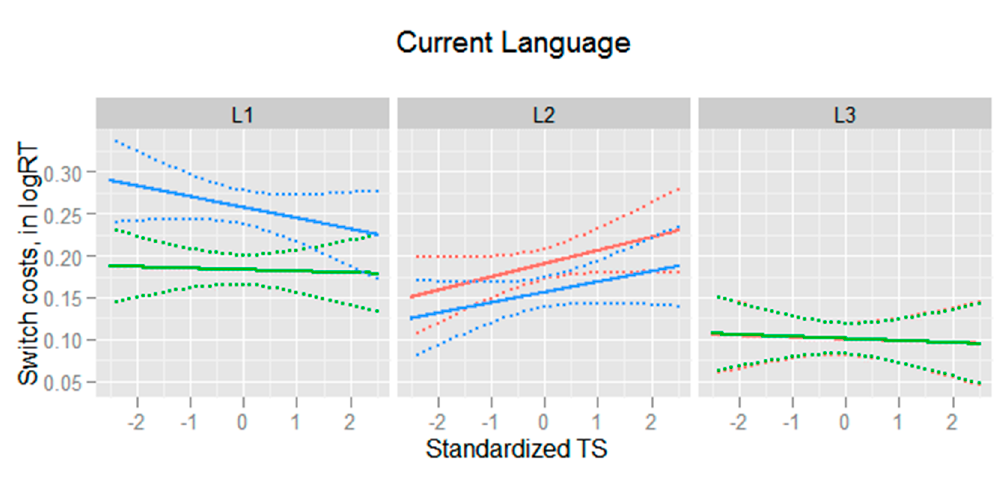
Figure 6. Relationship between task-switching switch costs and language switch costs (in log RT) by the language on the current trial. A larger standardized task-switching (TS) score indicates better task-switching abilities (as indicated by smaller switch costs). Dotted lines indicate 95% confidence bands.